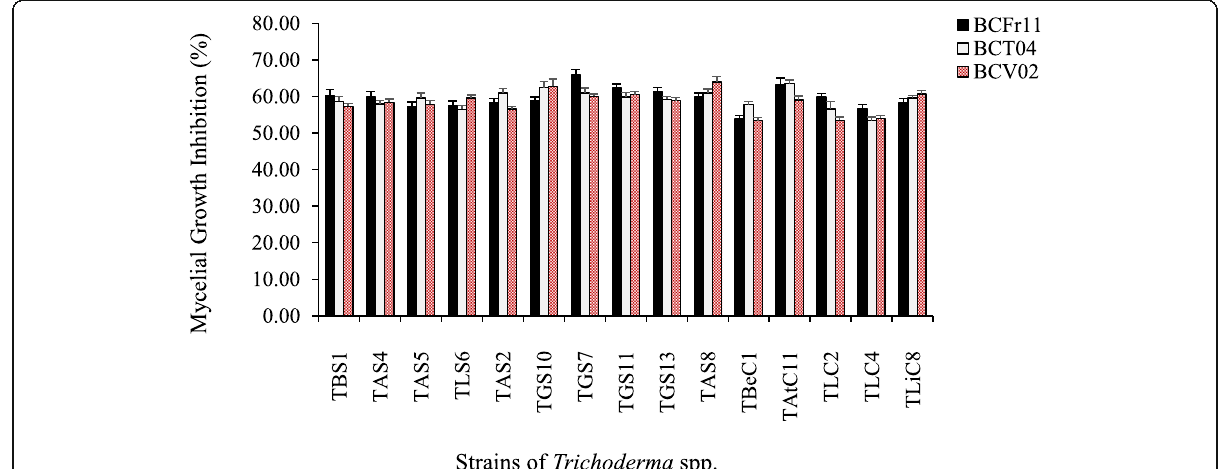
Fig. 3 Mycelial growth inhibition of three isolates of B. cinerea caused by 15 isolates of Trichoderma spp. revealed by the dual-culture test. Values are the mean of technical and biological replicates